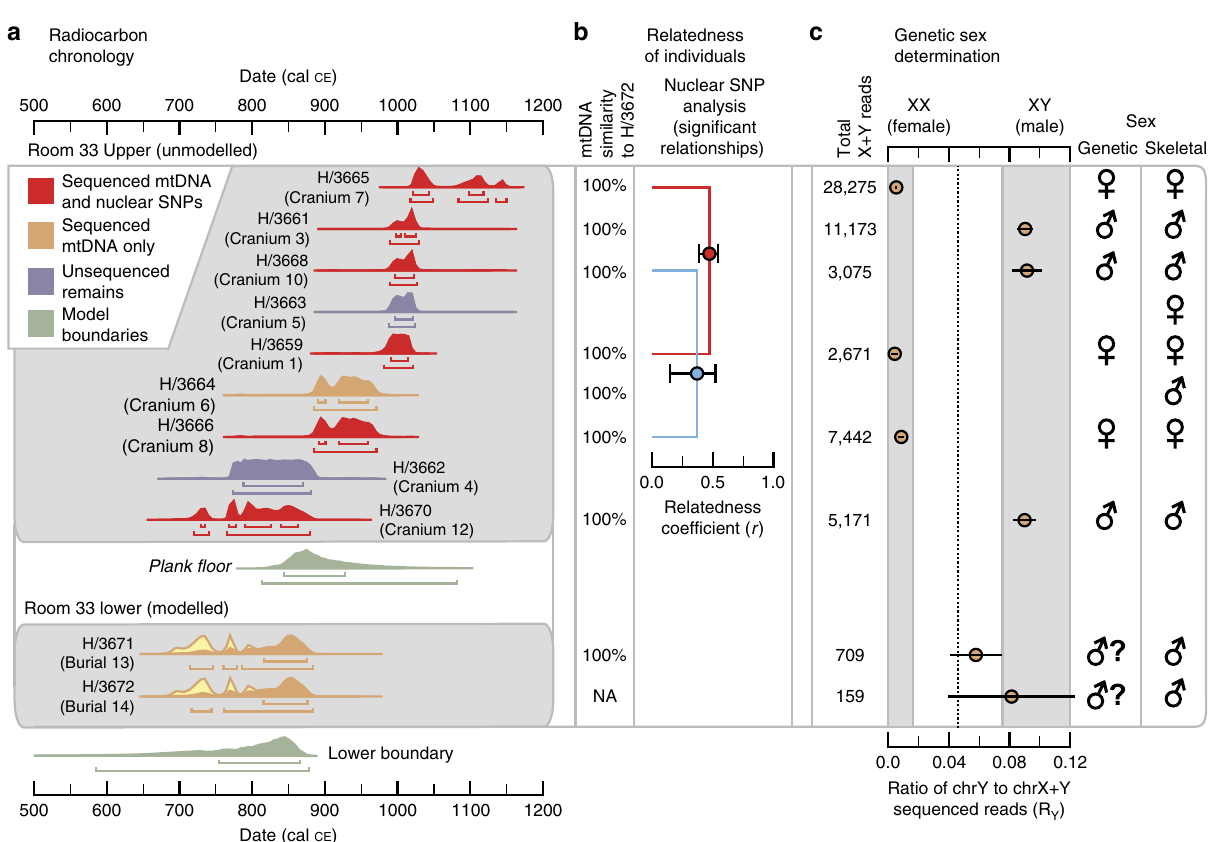
Figure 2 | Radiocarbon and archaeogenomic results for individuals buried in room 33. ( a ) Bayesian chronological model of calibrated AMS 14 C dates for burials 13 and 14 and the estimated age of the wood plank floor, and calibrated AMS 14 C dates for nine other crania above the floor in room 33. Calibrated 67.2 and 95.4% AMS date ranges and calibrated posterior probability distributions are illustrated for each cranium. ( b ) Archaeogenomic relatedness results for mtDNA (nucleotide sequence similarity to burial 14) and the nuclear genome. For the nuclear genome analysis, the estimated relatedness coefficient r (with the 95% confidence interval) is shown for each of the two pairs of individuals with significant genetic relationships. ( c ) The ratio Ry of the number of non-redundant sequence reads for each individual that mapped to human chromosome Y to the number of total reads that mapped to chromosomes X and Y, with the total number of X þ Y reads and the 95% confidence interval indicated. Shaded areas indicate the Ry boundaries corresponding to confident male and female designations, determined with individuals of known sex 25 . The genetic sex estimates are compared with those from a previous osteological analysis 18 . Graphical layout: T. Harper. The radiocarbon plot on the left was produced in OxCal 4.2 and graphs b and c were produced in Grapher 10.5. All subsequent layout and design were performed in Illustrator CC